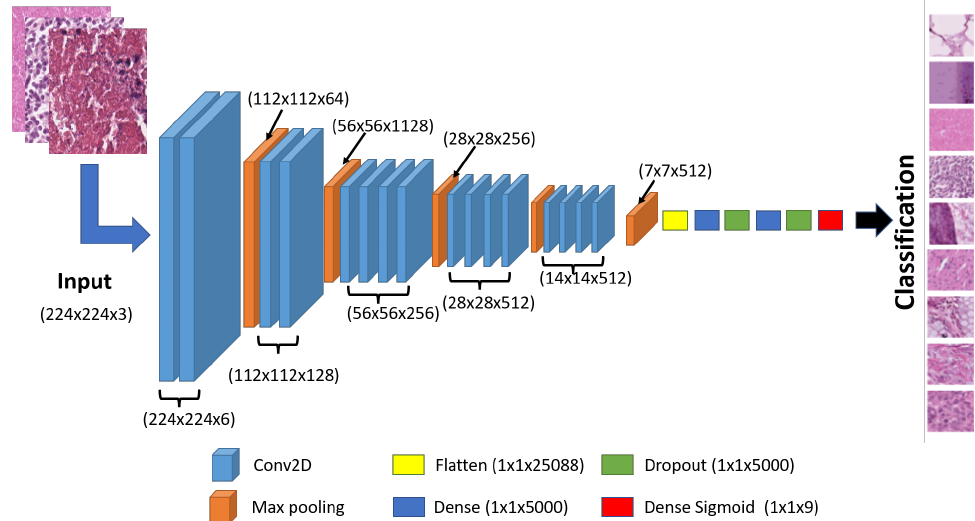
Figure 6. Architecture of the VGG19. Figure showing the convolutional layers in blue, the Maxpool layers in orange, and the final 6 designed layers added to the typical VGG19 neural network. The flatten layers are shown in yellow, the dense layers in dark blue, the green color represents dropout and finally the red dense sigmoid layer to classify the 9 different